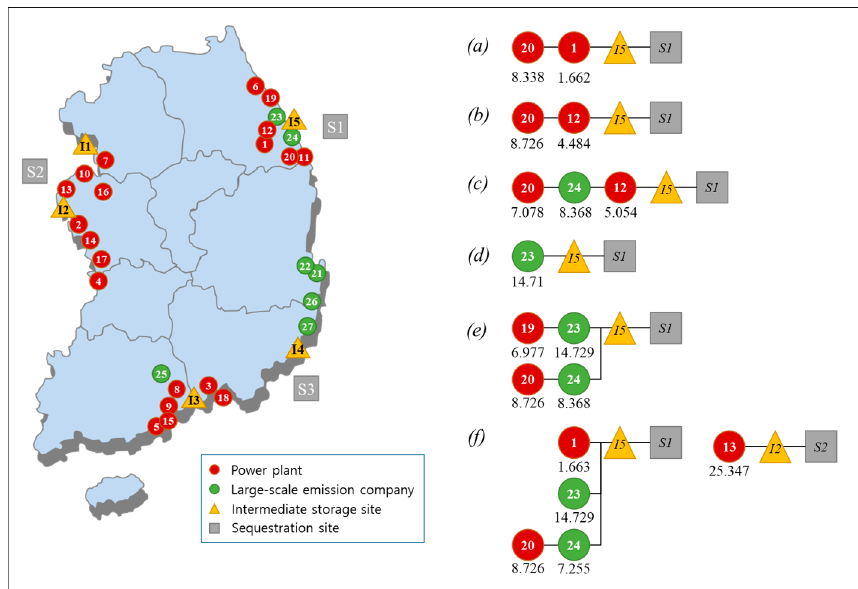
Figure 2. Display of optimal network by scenario.